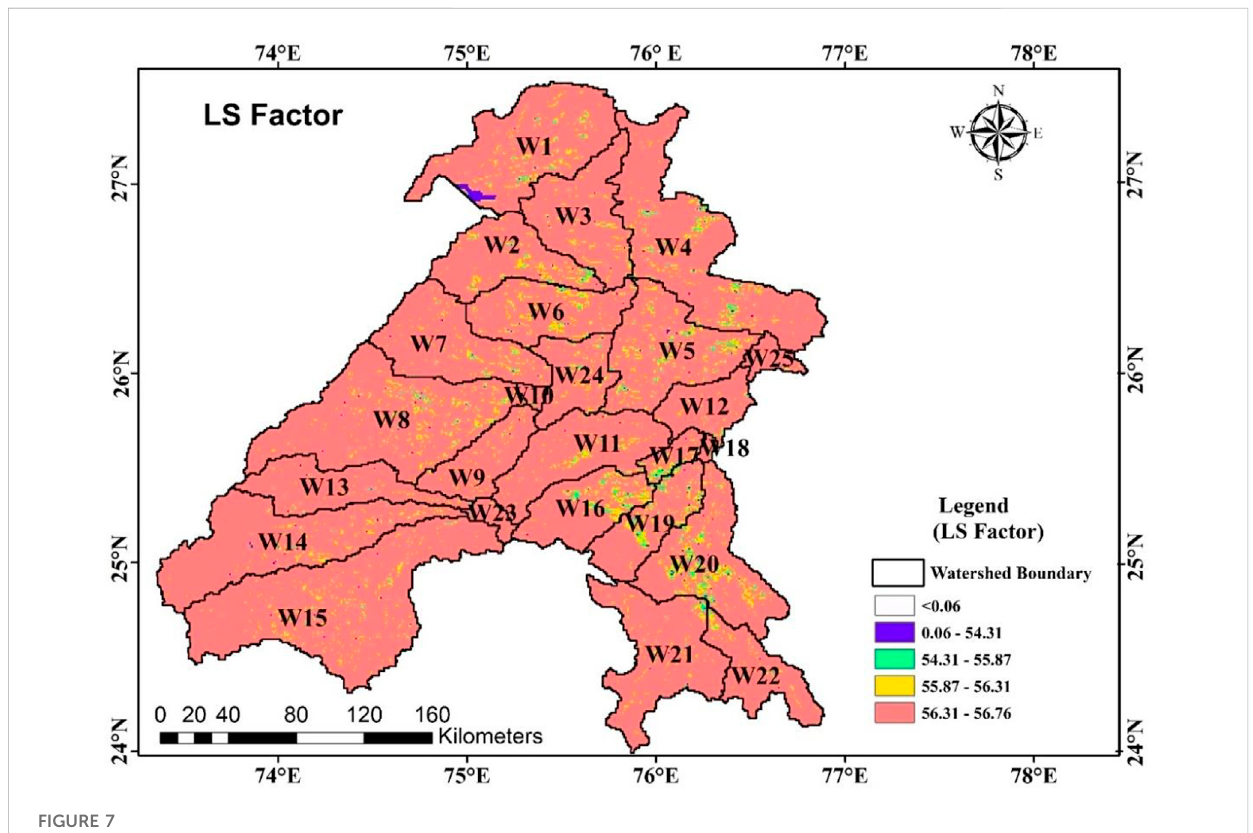
LS factor map of the study